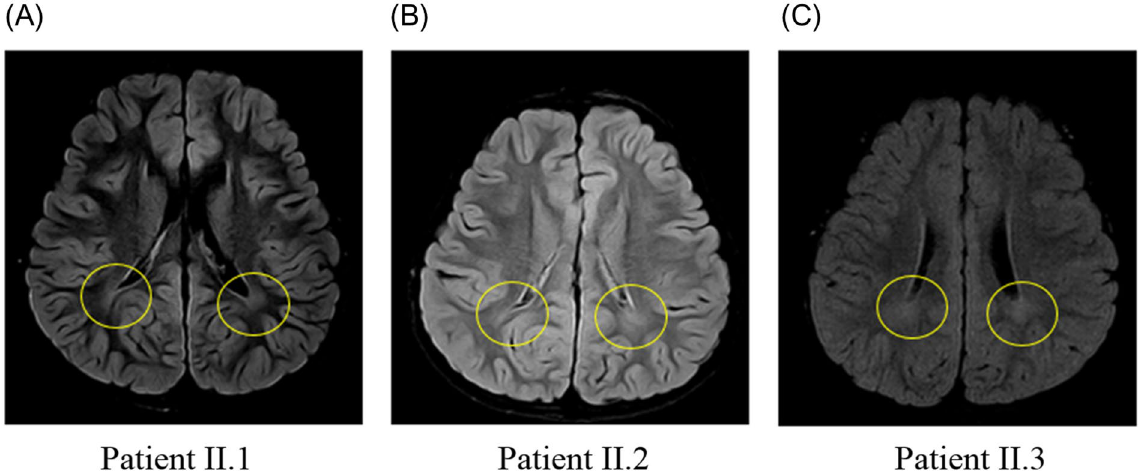
Figure 3. Fluid-attenuated inversion recovery (FLAIR) magnetic resonance image of patients. ( A , Patient II.1; B , Patient II.2; C , Patient II.3) FLAIR imaging shows ill-defined lesion of periventricular white matter which is shown in yellow circle.